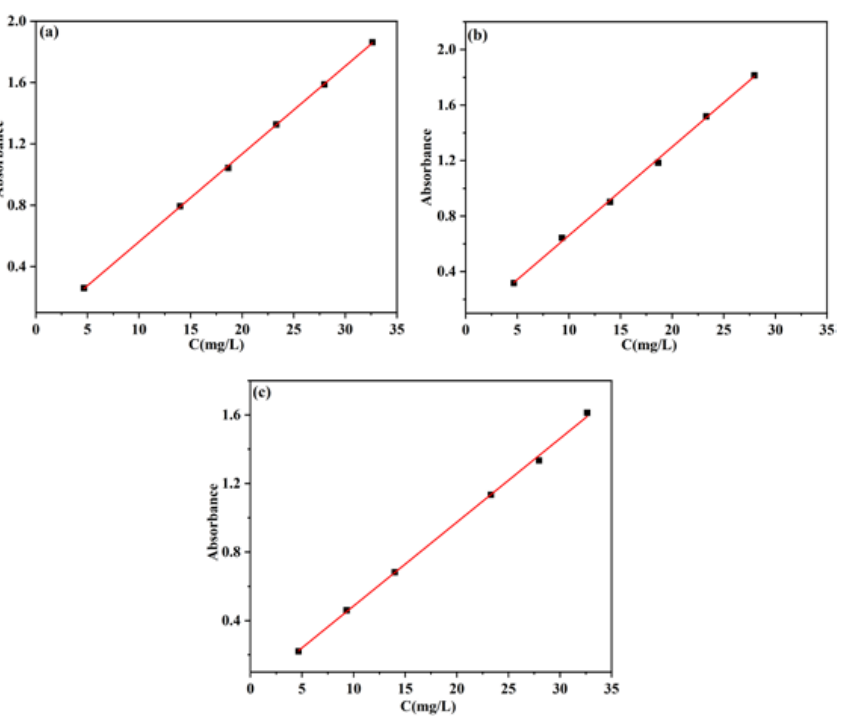
Figure 10. Calibration plot of the absorbance of 5-Fu toward concentration under pH = 1 ( a ), pH = 5.0 ( b ), pH = 7.4 ( c ). Table 4. Correlation equation and coefficient ( R 2 ) under different pH values.